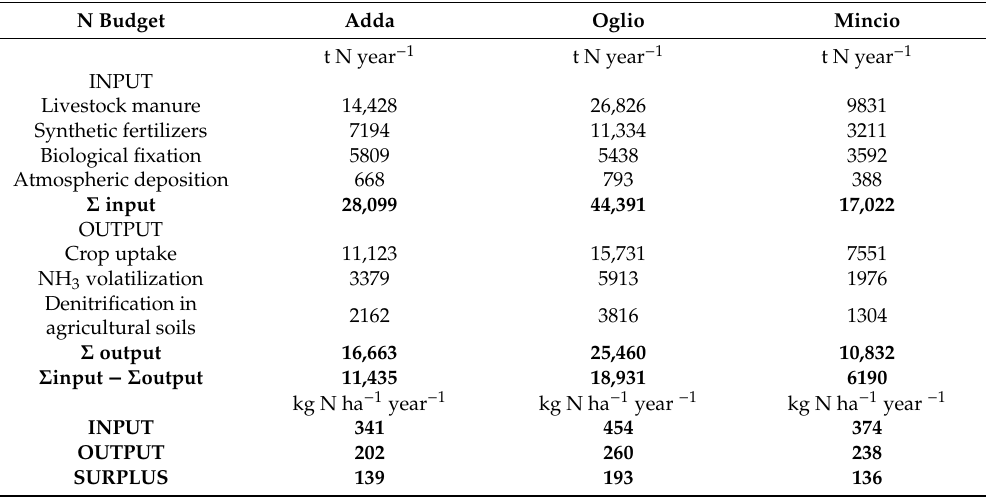
Table 5. Nitrogen input, output, and surplus are reported in terms of total loads (t N year − 1 ) and areal loads (kg N ha − 1 UAA year − 1 ) in the portions of the three basins (Adda, Oglio, and Mincio) object of this study. Data source: [62]. Total input, total output and surplus are reported in